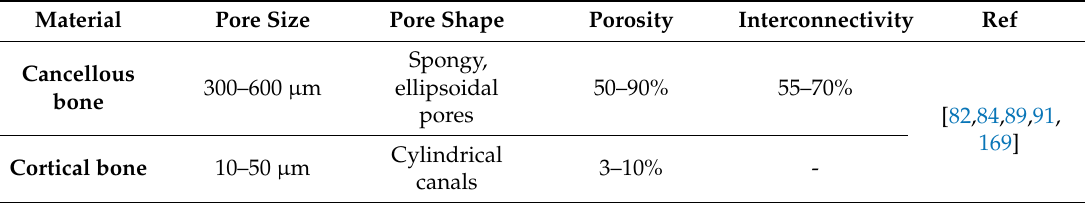
Table 5. Summary of dimensional properties of natural human bone.